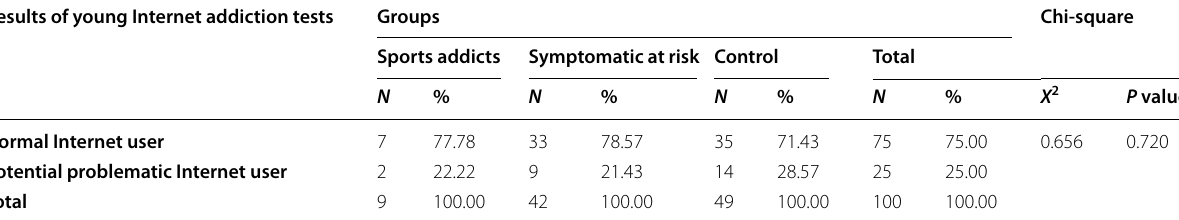
Table 2 Internet Addiction Test among studied sports addicts and control Results of young Internet addiction tests